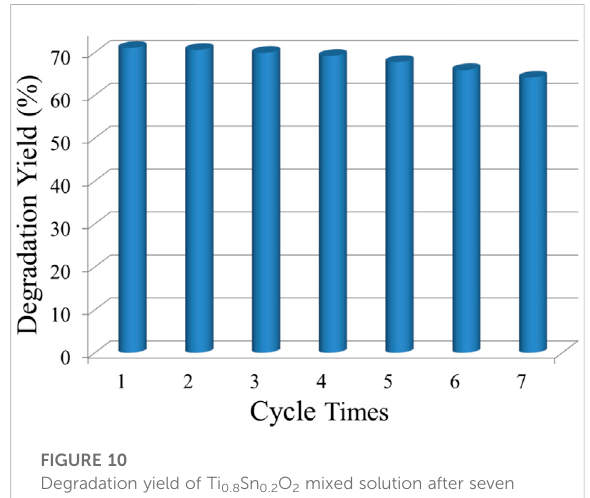
FIGURE 8 Variation in optical band gap of Ti 1-x Sn x O 2 (0 < x < 1) samples. Dashed line is a linear interpolation between the band gap values for anatase TiO 2 (3.2 eV), rutile TiO 2 (3.0 eV), and SnO 2 (3.60 eV).